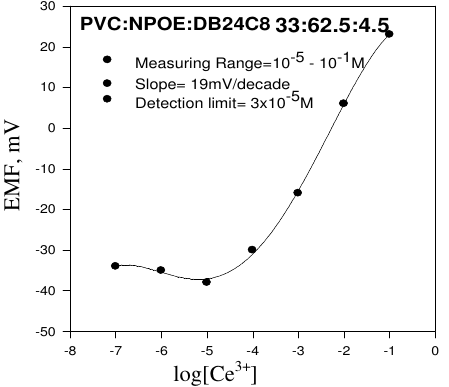
Figure 1. Calibration curve for Ce(III)- selective electrode based on DB24C8.